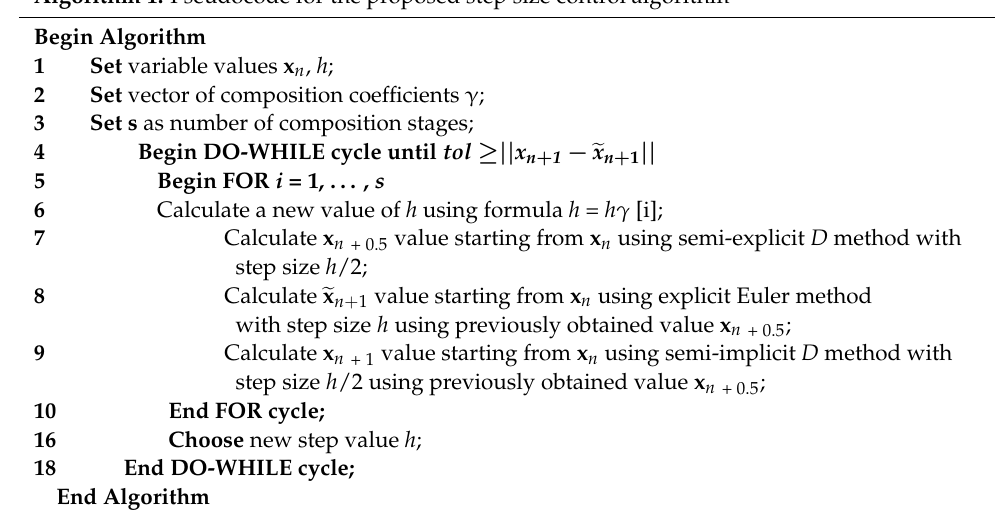
Algorithm 1. Pseudocode for the proposed step size control